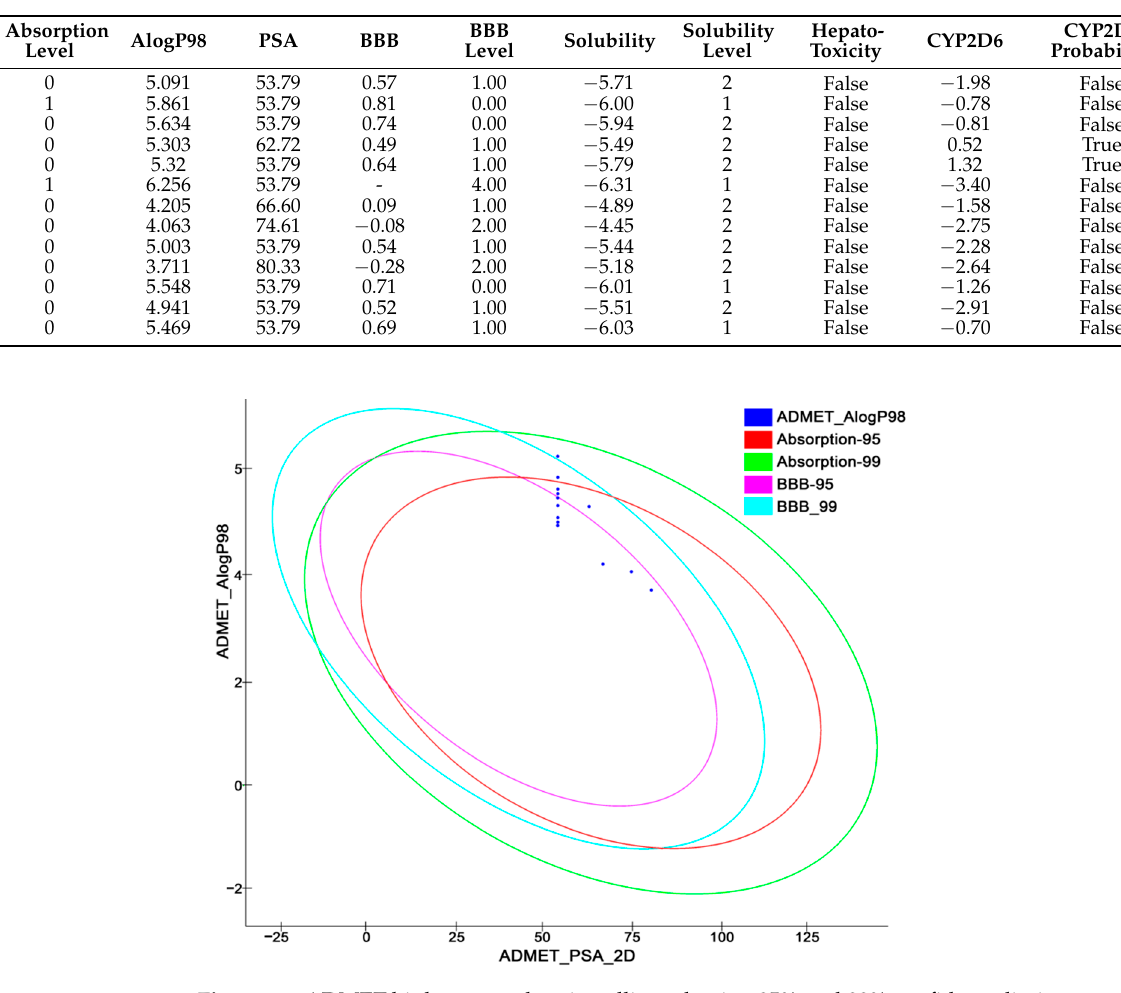
Figure 18. ADMET biplot curve showing ellipses having 95% and 99% confidence limits corresponding to the blood–brain barrier and intestinal absorption models.